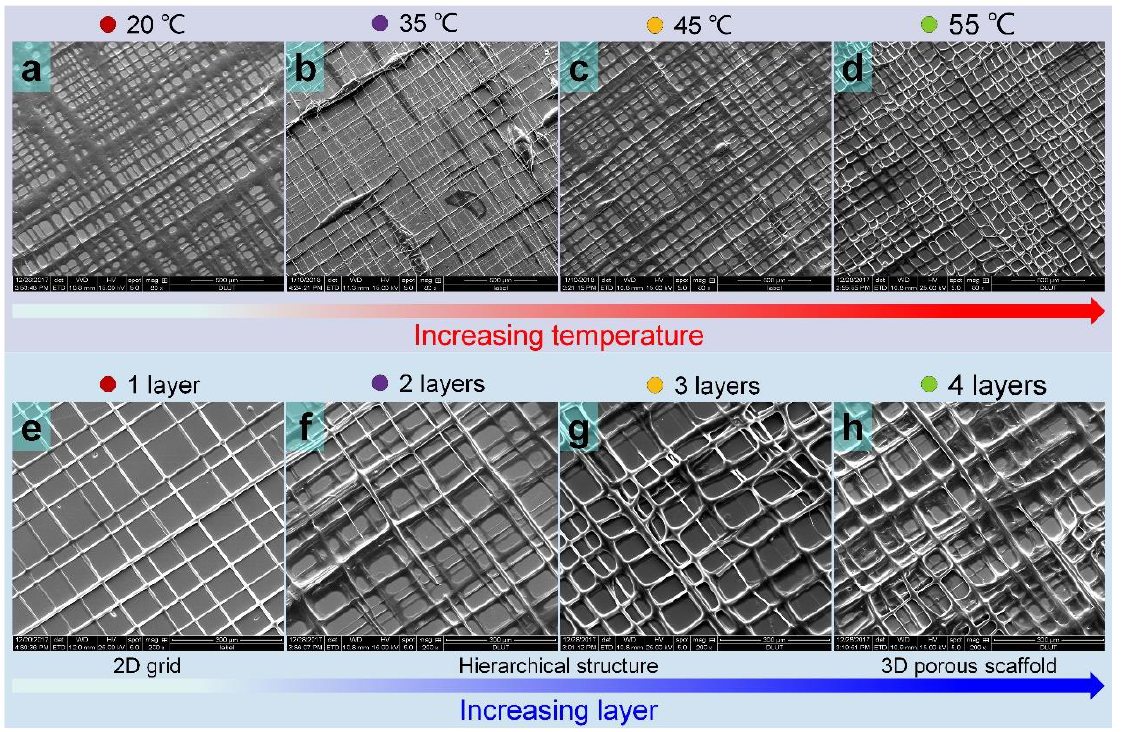
Figure 7. SEM images of TVEJ printed composite osteochondral scaffolds. ( a – d ) Printing a four-layer scaffold at different temperatures; ( e – h ) Printed scaffolds with a different layer at 55 °C.